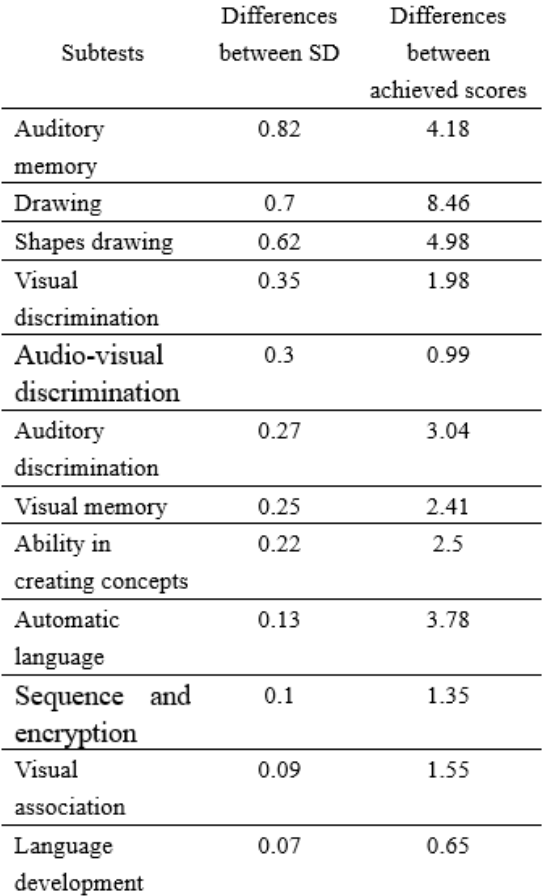
Table 6. Development skills of students in the control group sorted by the intensity of development during the school